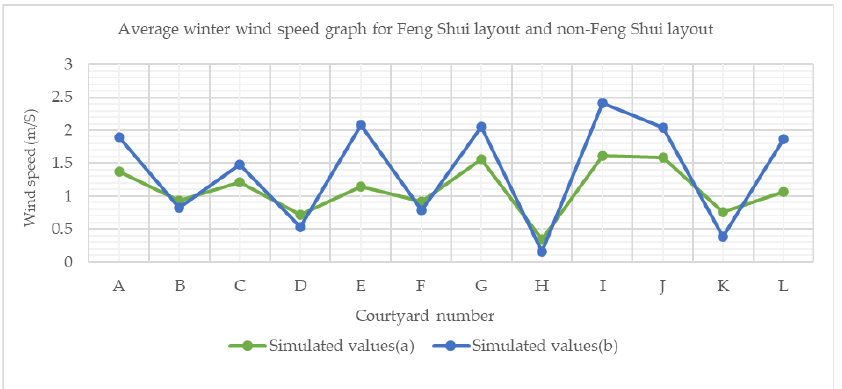
Figure 15. The line graph depicts the average wind speeds of courtyards under Feng Shui and non-Feng Shui layouts. The data for the graph were obtained through CFD simulations.